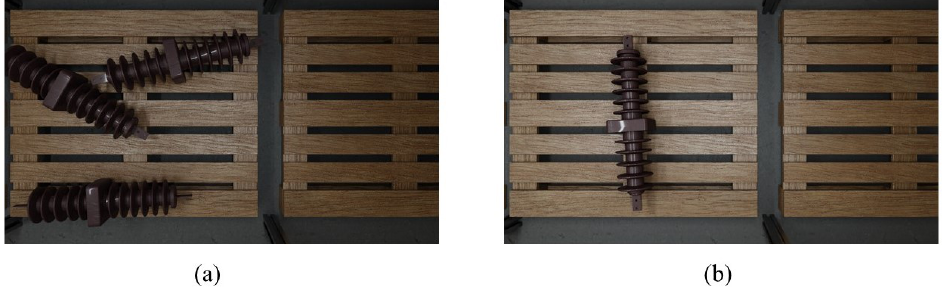
Figure 6. Rendered images: ( a ) Cycles and ( b ) Eevee.